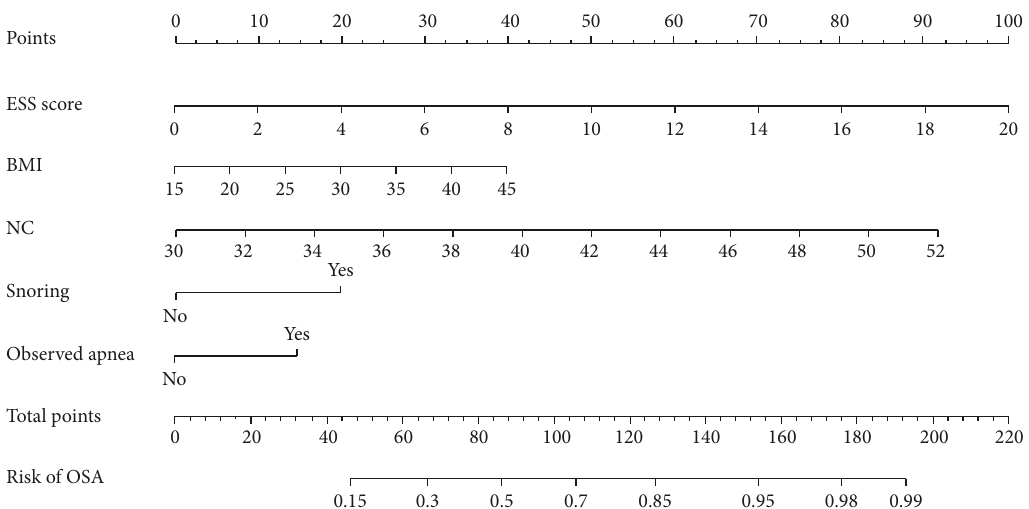
Figure 2: Proposed nomogram for OSA prediction (e.g., a resident with ESS � 10, BMI � 30, neck circumference � 42, snoring, no observed apnea, the total point is 140 read from the above nomogram, and the corresponding risk of OSA is 0.90 [90%]). OSA, obstructive sleep apnea; BMI, body mass index; ESS, Epworth sleepiness scale; NC, neck circumference.